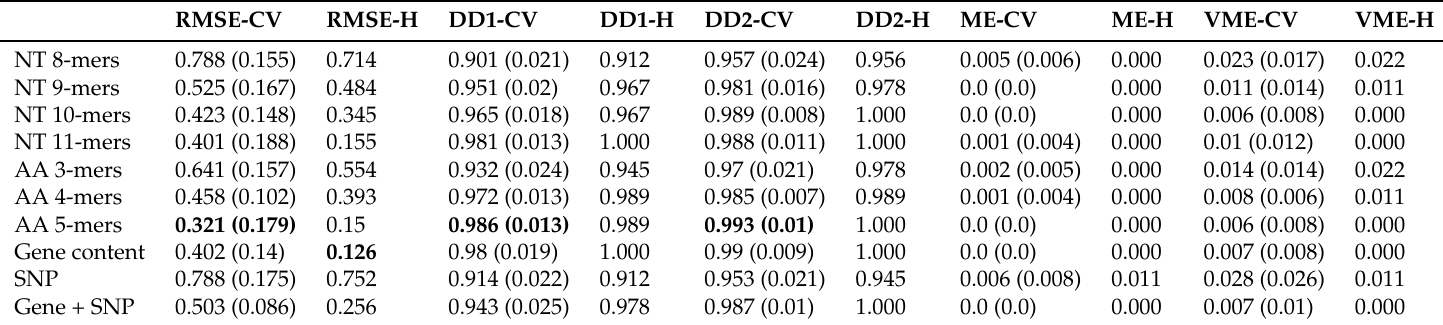
Table A59. S. enterica –kanamycin.